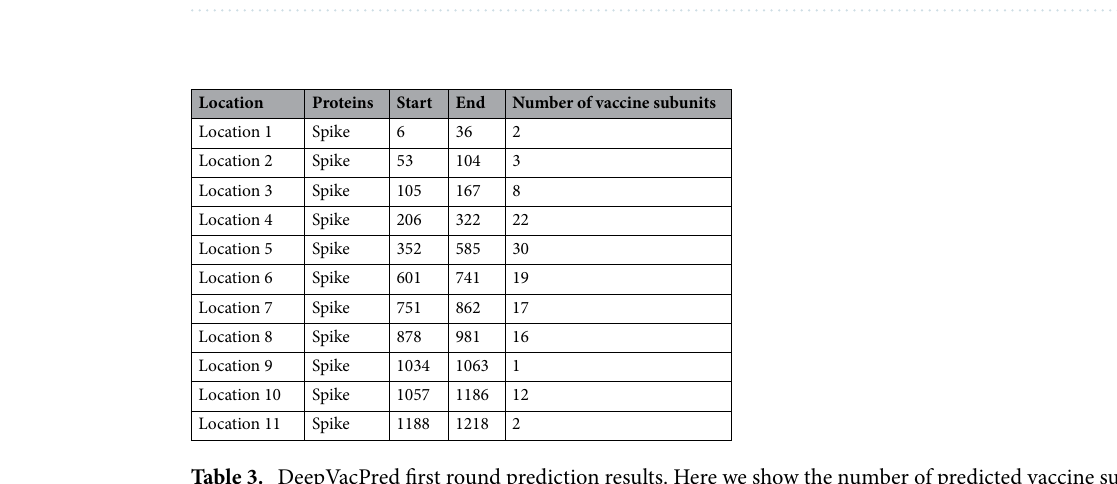
Table 2. DeepVacPred Validation. For the Training Set, we reach the highest accuracy of 0.995 if the threshold value is set at 0.32. At this threshold value, the sensitivity and specificity are 0.99 each. For the Testing Set, we reach the highest accuracy of 0.95 if the threshold value is set at 0.5. At this threshold value, the sensitivity and specificity are 0.95 each. The experimental data shows high accuracy and strong classification ability of the proposed DeepVacPred framework.